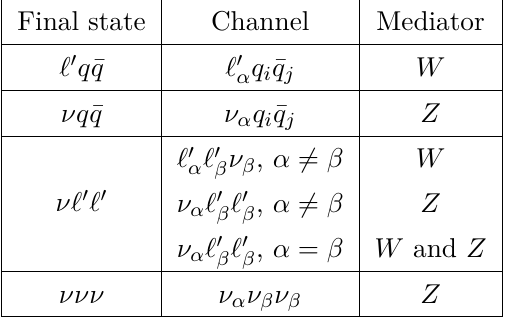
Table 1 . Possible decay channels for the RH neutrino N . Here α, β, i and j are flavor indices and, for simplicity, we do not specify neither the charge of the charged lepton ‘ 0 = e, µ, τ nor the nature of the (anti)neutrino. In this table we have grouped together the three decay modes giving rise to the ν‘ 0 ‘ 0 final state since, given that both the W and Z boson will be non resonant for the RH neutrinos mass range of our interest, these processes will not be distinguishable. Moreover, the ν